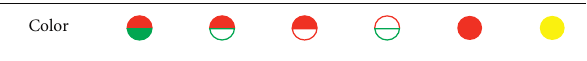
Road stud light patterns Color Figure 2: Different patterns of intelligent road stud